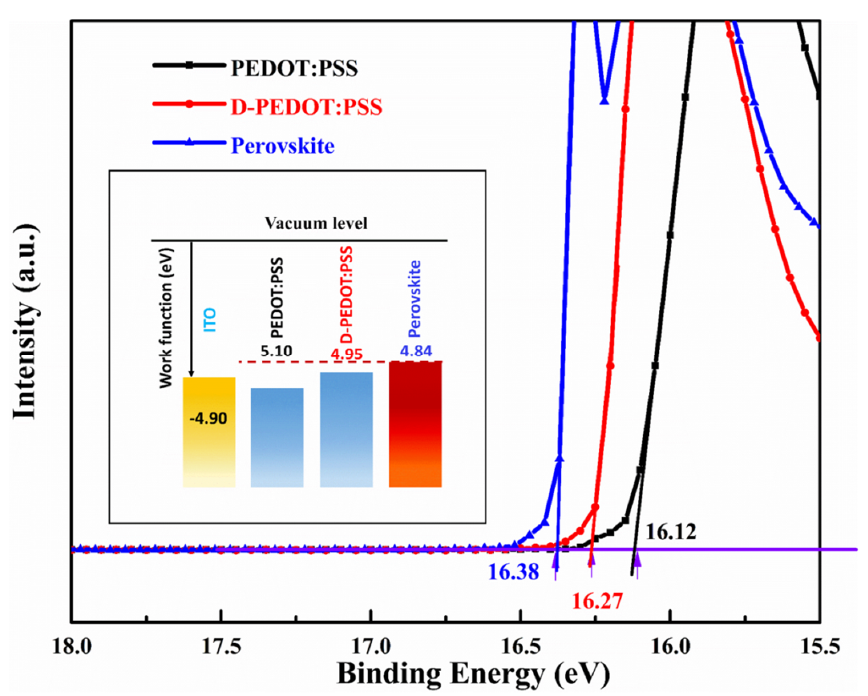
Figure 6. UPS spectra of PEDOT:PSS, D-PEDOT:PSS and perovskite film; the inset is the schematic diagram of energy level